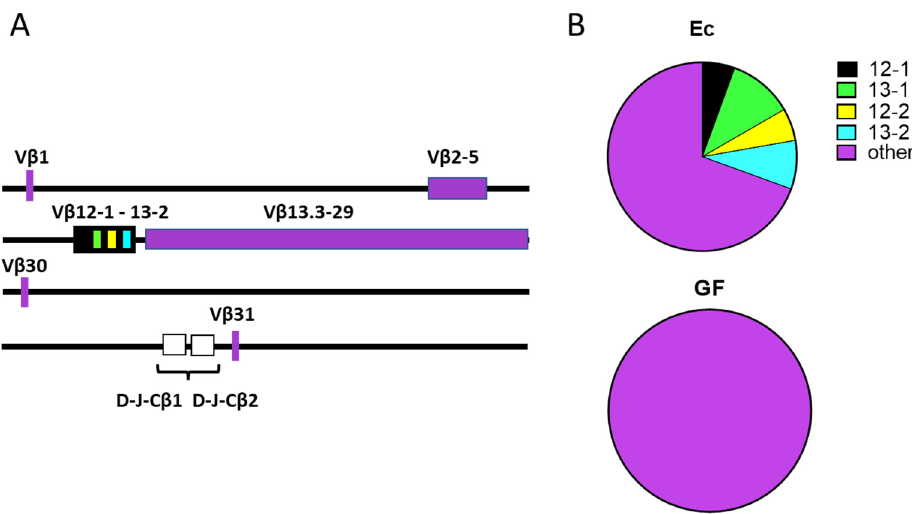
Figure 1. Percentages of REP sequences among all unique TCR β sequences in Ec and GF mice. Percentages are shown for the numbers of REP sequences in Ec and GF mice in three independent experiments examined individually and together (All). There were 2 Ec and 2 GF mice in experiment 1, 4 Ec and 4 GF mice in experiment 2, and 2 Ec and 4 GF mice in experiment 3. In each experiment, REP frequencies were higher in Ec mice compared to GF mice. REP frequencies were significantly different between mouse groups in experiment 2 (the largest experiment), and in sequences from combined experiments. Fishers Exact tests were used.